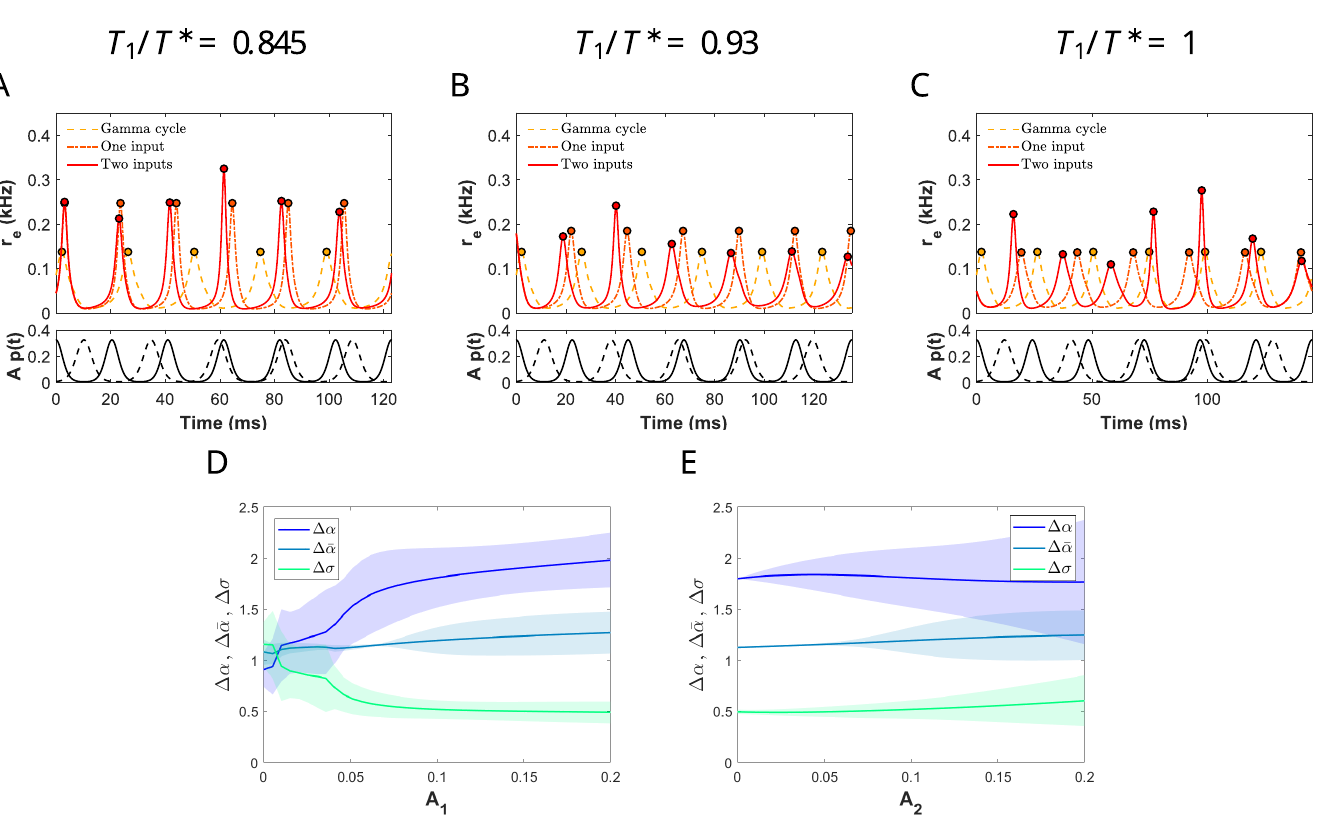
Fig 7. Effects of the disruptor on the E-cell evoked response for some representative trails. Three different types of entrainment inside 1:1 phase-locking region for system (1)-(2) in the absence of corresponding to (A) T 1 / T � = 0.845, (B) T 1 / T � = 0.93 and (C) T 1 / T � = 1. (Top) Time evolution of the excitatory firing rate r e perturbation (dashed yellow curve), when the network is entrained by the primary input (dashed-dotted orange curve) and when both the primary input and the distractor are present (solid red curve) for a time duration of 6 T 1 . (Bottom) The primary input (solid black) and the distractor (dashed black) correspond to inputs of von Mises type with A 1 = A 2 = A = 0.1, κ 1 = κ 2 = 2 and a frequency relationship T 2 / T 1 = 1.2. (D, E) Factors Δ α , Δ σ and D � a describing changes in the E-cell evoked response for the case T 1 / T � = 0.845 (primary on the left-hand side of the Arnold tongue) and T 2 / T � = 1.2 T 1 / T � = 1.04 (distractor on the right-hand side of the Arnold tongue) when (D) the amplitude of the primary A 1 is varied from 0 to 0.2 while keeping the amplitude of the distractor fixed at A 2 = 0.1 and (E) viceversa. We have computed the mean and standard deviation of these factors over 10 cycles of the primary